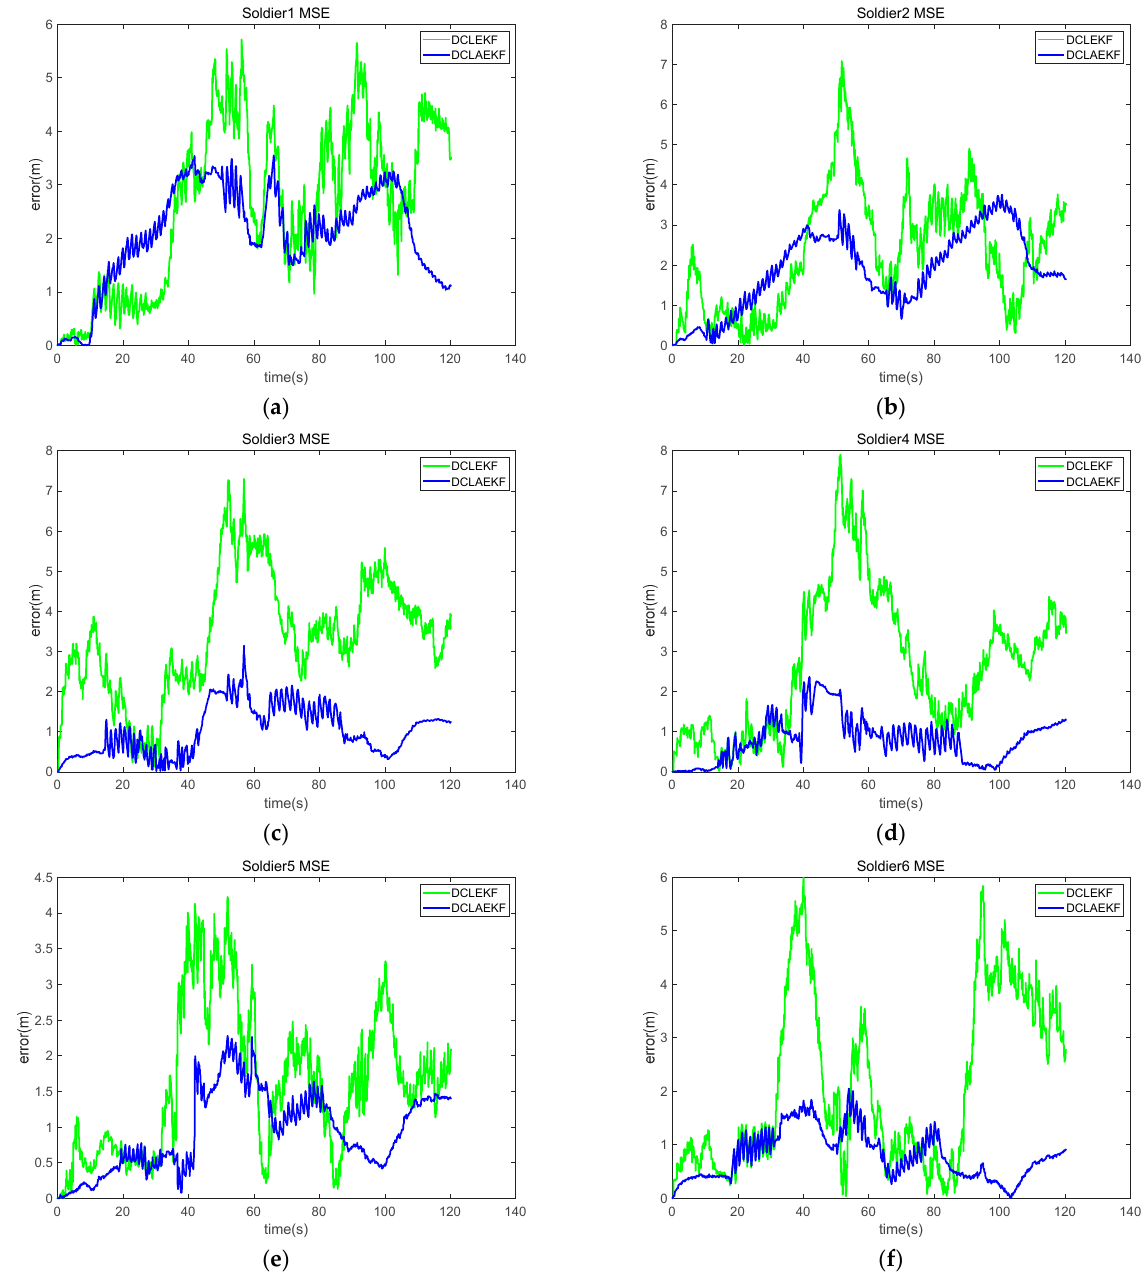
Figure 11. MSE curves of soldiers in a forest environment experiment. ( a ) MSE of soldier 1; ( b ) MSE of soldier 2; ( c ) MSE of soldier 3; ( d ) MSE of soldier 4; ( e ) MSE of soldier 5; ( f ) MSE of soldier 6.